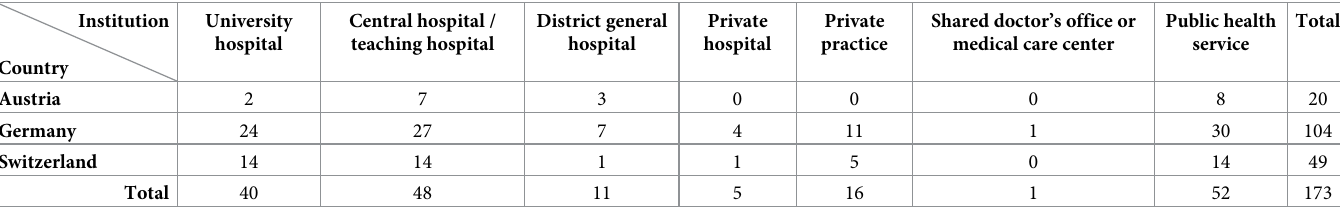
Fig 1. Number of survey respondents per federal state or canton, respectively. Reprinted under a CC BY license, with permission from [Daniel Dalet], original copyright [2020]. https://doi.org/10.1371/journal.pone.0250387.g001 in Germany, and 7/49 (14.3%) in Switzerland while both IGRA tests were used by 9/104 (8.7%) in Germany, 4/20 (20.0%) in Austria and 6/49 (12.2%) in Switzerland, respectively. Ninety-one/173 (52.6%) of the respondents reported to have been affected by the 2016 shortage of PPD RT 23 SSI tuberculin. In 18/91 (19.8%) cases an alternative tuberculin was used. Three respondents from Germany (3.3%) stated to rather use TST in younger children, but were forced to switch to IGRA testing due to this PPD RT 23 SSI shortage. Radiology For the diagnosis of LTBI in children > 5 years of age, the most common procedure reported to exclude TB-disease (48/173, 27.7%) was performing a chest-x-ray in case of an either posi- tive IGRA or TST. Table 1. Institutional and geographical background of survey